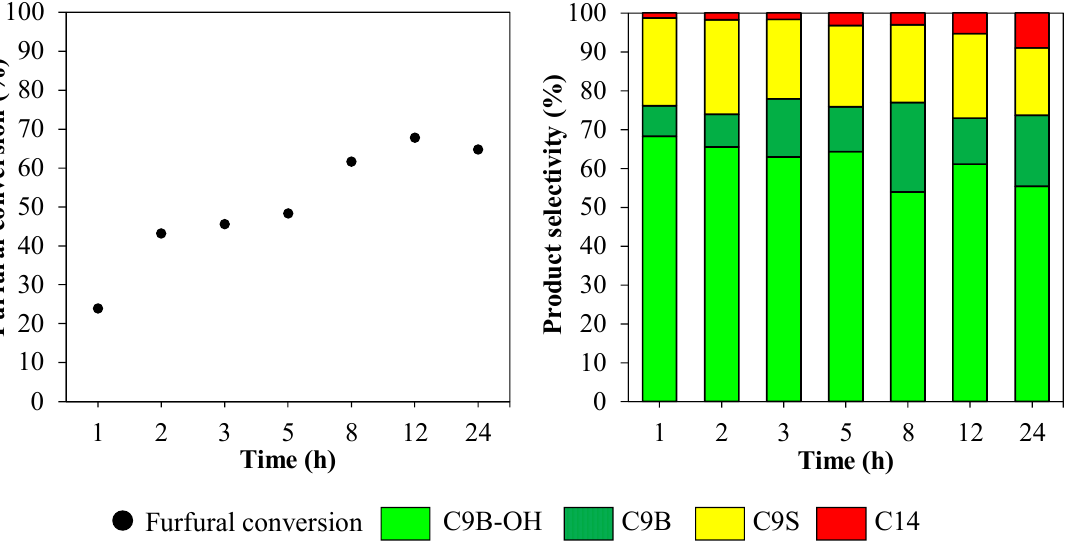
Figure 5. Effect of reaction time on furfural conversion and product selectivity obtained from aldol condensation of furfural and 2-butanone over LDO3 catalyst. (Reaction conditions: furfural:2-butanone, 1:5; catalyst loading, 5 wt.%; temperature, 120 ◦ C; N 2 pressure, 10 bar).